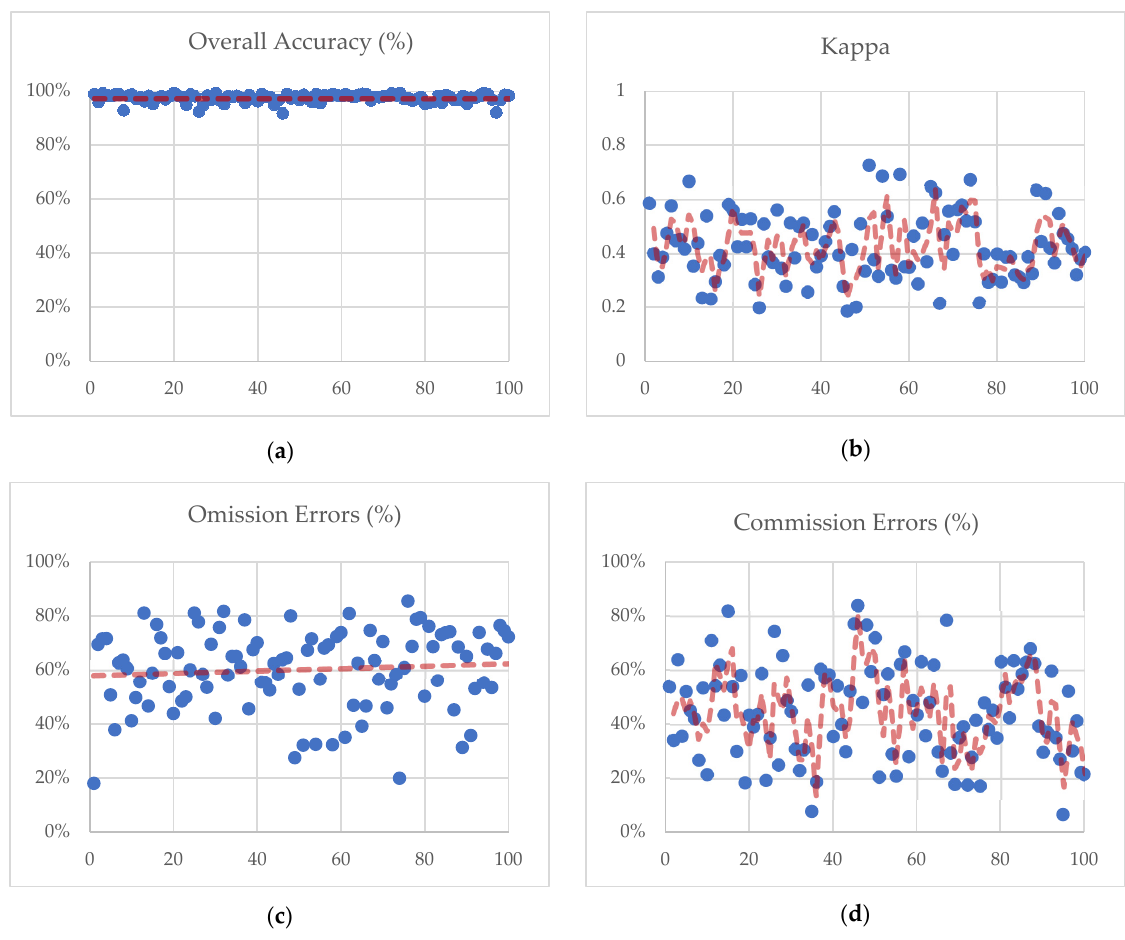
Figure 18. Performance of dam segmentation without the SLIC algorithm. The blue dots indicate the evaluation results of the 100 test images, and the dark red dotted lines represent the trend lines for ( a ) overall accuracy, ( b ) Kappa, ( c ) omission errors, and ( d ) commission errors. Table 6. Accuracy comparison of dam segmentation results with and without the SLIC algorithm. (A check mark means the method is used.)